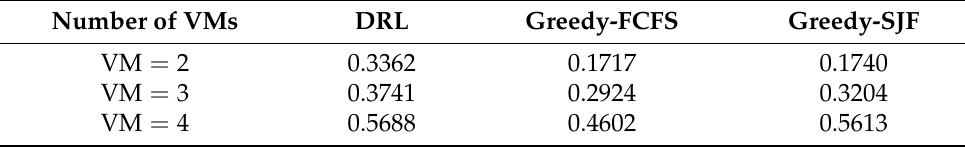
Table 4. Comparison of the task success